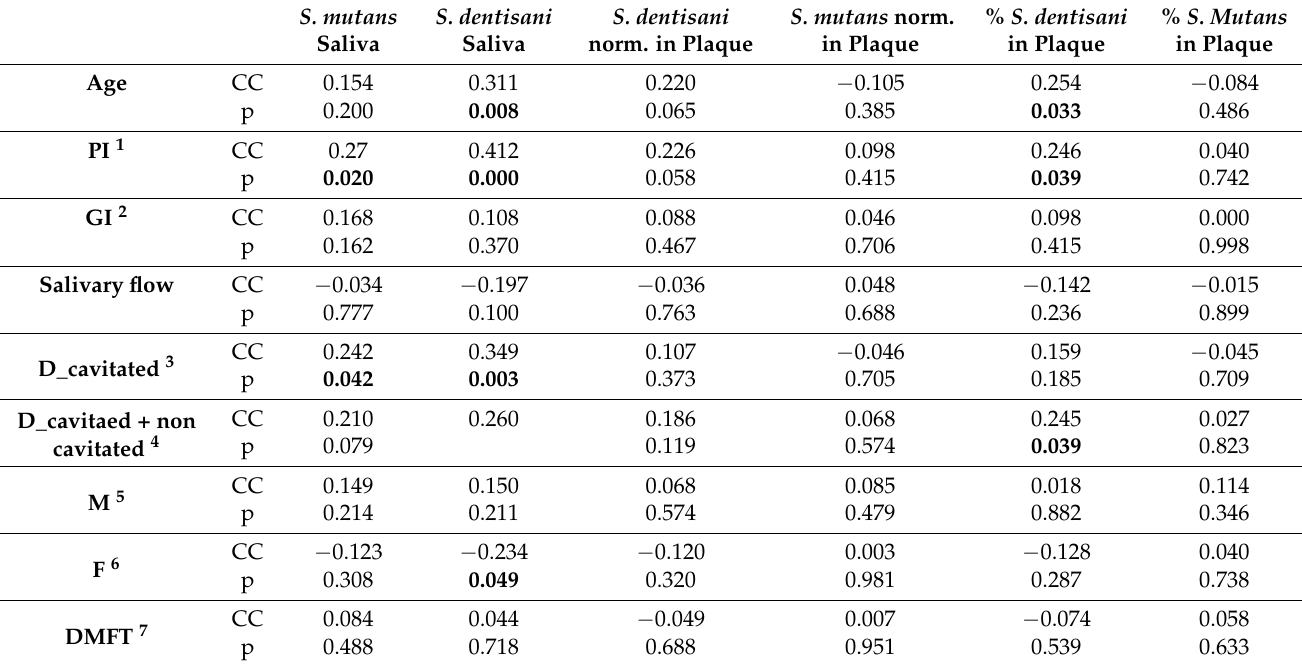
Table 2. Correlation analysis (Correlation Coefficient, CC and p -value) between the levels of S. mutans and S. dentisani in saliva or plaque with different caries indices and biochemical